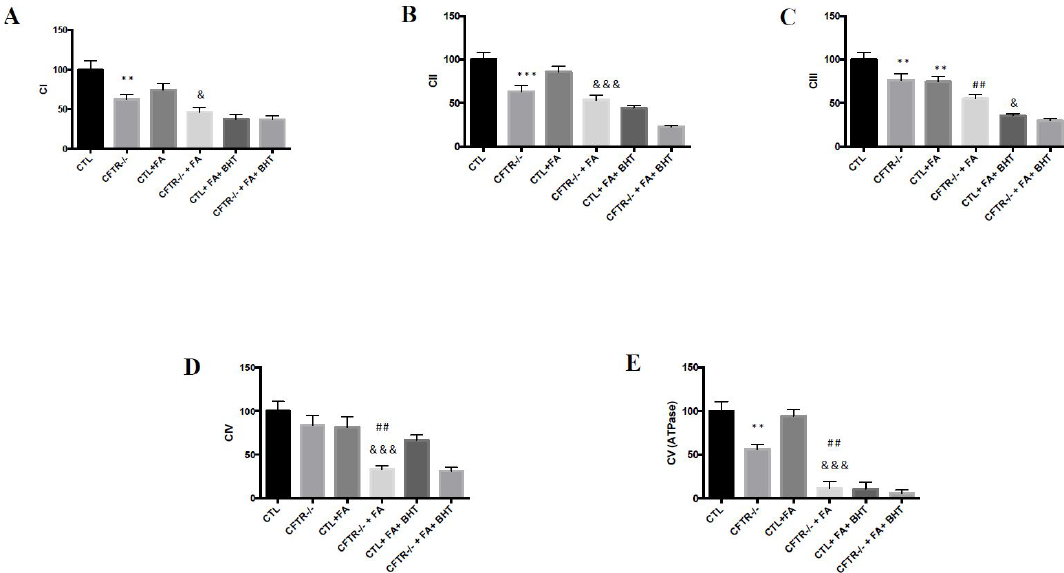
Figure 4. Effect of CFTR abrogation on mitochondrial oxidative phosphorylation. After 15 days differentiation, Caco-2/15 cells were trypsinized and mitochondria were isolated by ultracentrifugation to assess the protein mass by western blotting of ( A ) respiratory chain complex I (CI); ( B ) complex II (CII); ( C ) complex III (CIII); ( D ) complex IV (CIV); and ( E ) complex V (CV). Values are means ± SEM of 5 independent experiments, each performed in triplicate. ** p < 0.01, *** p < 0.001 vs. CTL cells; ## p < 0.01 vs. CFTR -/- cells; & p < 0.05, &&& p < 0.001 vs. CTL + FA cells. CTR: control cells; FA: